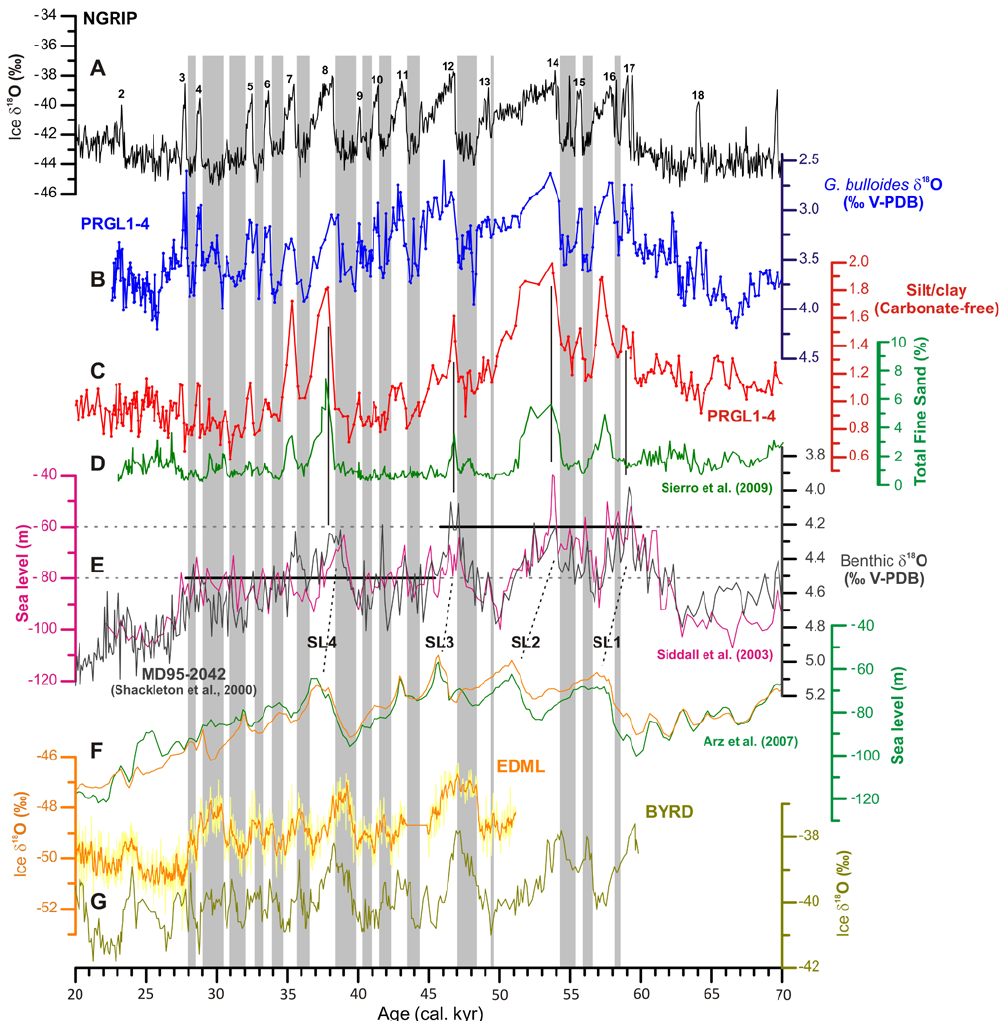
Fig. 5. Comparison of different records of climate variability and sea-level reconstructions for the MIS 3 period, all of them age-scaled to the Greenland ice core NGRIP (Svensson et al., 2008) (A) . (B) G. bulloides oxygen isotopic record (blue), (C) carbonate-free silt/clay ratio (red) and (D) total fine sand fraction (green) from PRGL1-4 borehole. (E) Benthic oxygen isotopic record from MD95-2042 (Shackleton et al., 2000) (dark grey) compared to Red Sea sea level reconstruction (Siddall et al., 2003) (pink), with horizontal lines showing that mean sea level was ∼ 20m higher in early MIS 3 than in late MIS 3. Discontinuous lines point four millennial-scale peaks of relative high sea level (SL1, 2, 3 and 4). (F) Sea level reconstructions from the northern Red Sea based on two different temperature corrections for the deep basin (Arz et al., 2007). (G) Oxygen isotopic records from Antarctic ice cores EDML and BYRD (Blunier and Brook, 2001; EPICA Community Members, 2006) CH 4 -synchronized to Greenland ice core NGRIP (Svensson et al., 2008). Numbers above the NGRIP record represent warm GIS, while vertical grey bars correspond to cold GS and